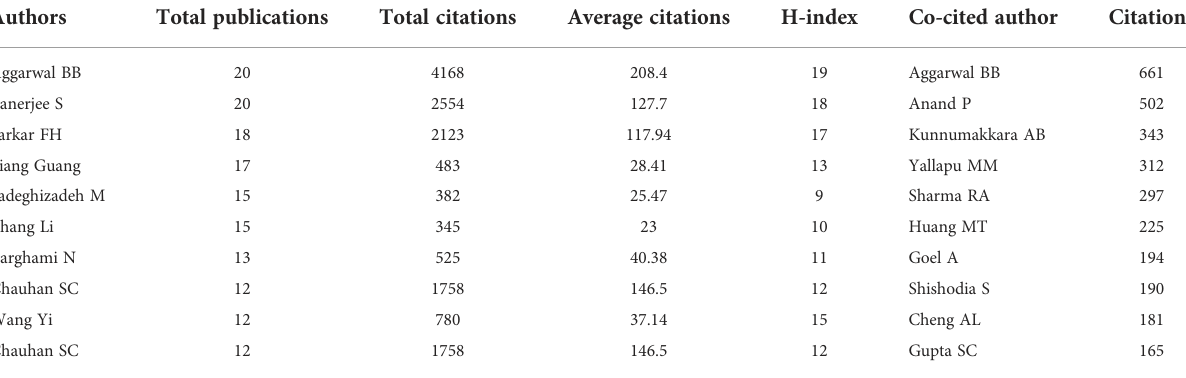
TABLE 3 The top 10 authors and co-cited authors that contributed publications on curcumin.